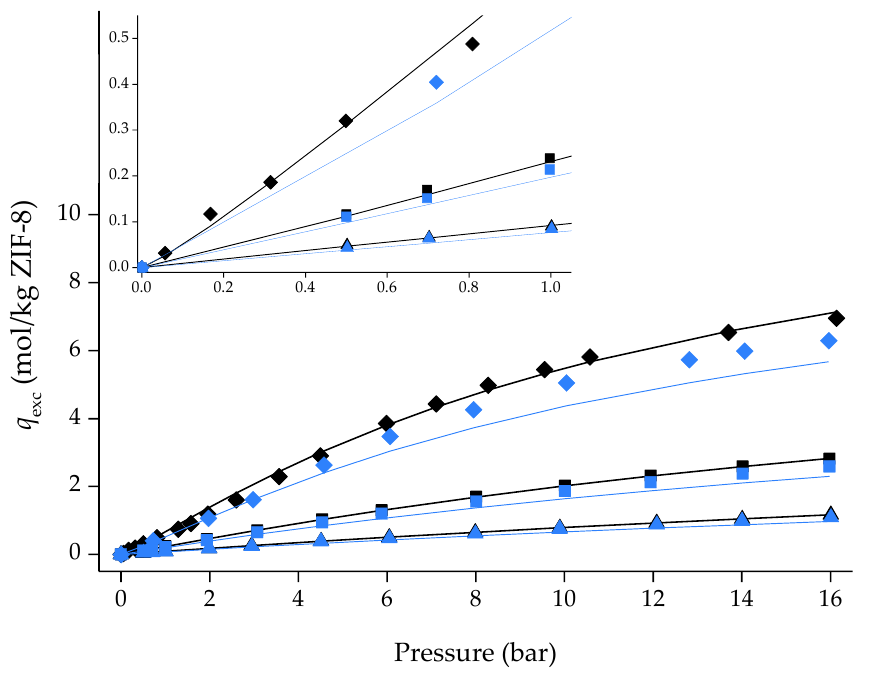
Figure 8. Single-component adsorption/desorption equilibrium isotherms of CO 2 , CH 4 , and N 2 on an IL-free basis in pristine ZIF-8 and [C 6 MIM][B(CN) 4 ]@ZIF-8 (low) at 303 K. Symbols denote both adsorption and desorption data. Lines represent the Sips adsorption isotherm model fitting the ex- perimental non-IL-free data points. Symbols: ◆ ZIF-8_CO 2 ; ◆ [C 6 MIM][B(CN) 4 ]@ZIF-8 (low)_CO 2 ; ZIF-8_CH 4 ; [C 6 MIM][B(CN) 4 ]@ZIF-8 (low)_CH 4 ; ZIF-8_N 2 ; [C 6 MIM][B(CN) 4 ]@ZIF-8 (low)_N 2 .